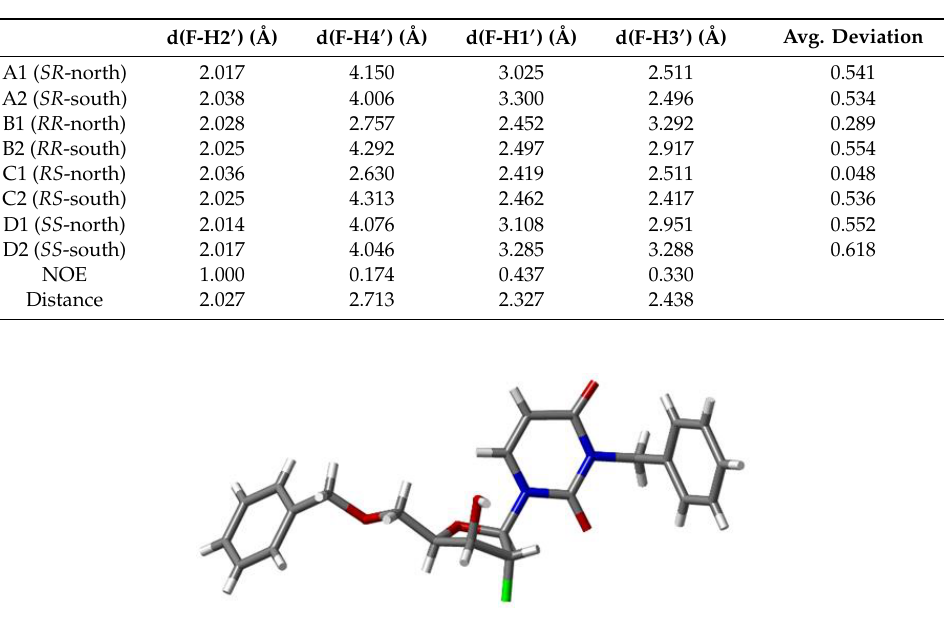
Table 2. Calculated and experimental distance values for conformers A1–D2 of compound 12 . Distances are shown in Å. Experimental values were recorded in CDCl 3.